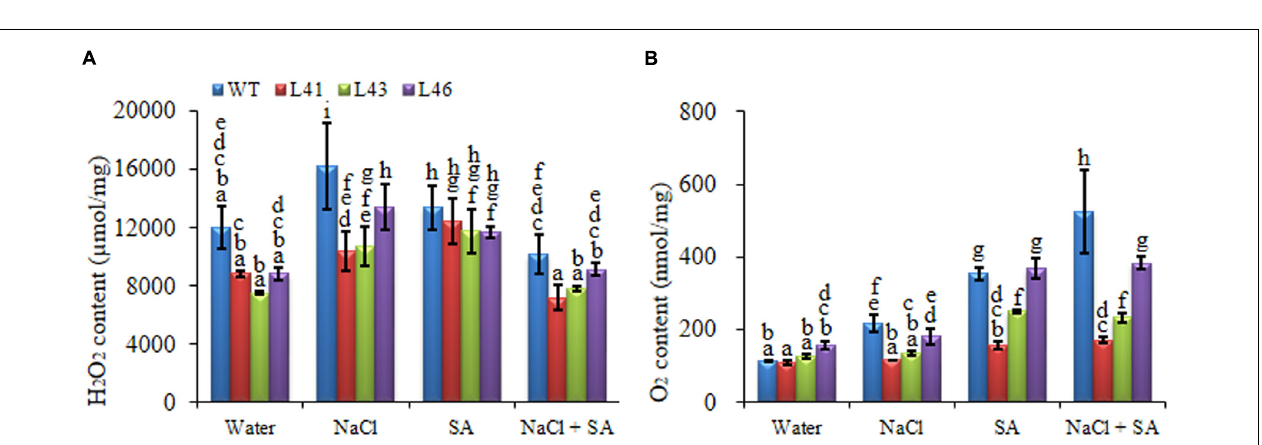
FIGURE 5 | Analysis of ion content in leaves of WT and JcWRKY transgenic tobacco plants with NaCl, SA and combinatorial stress. (A) Na + content, (B) K + content, (C) K + /Na + . Values are represented as mean ± SD ( n = 3).